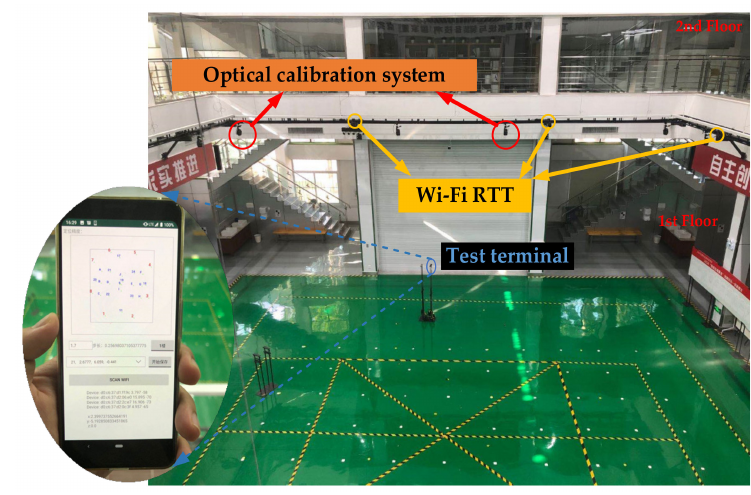
Figure 9. Positioning system test environment.